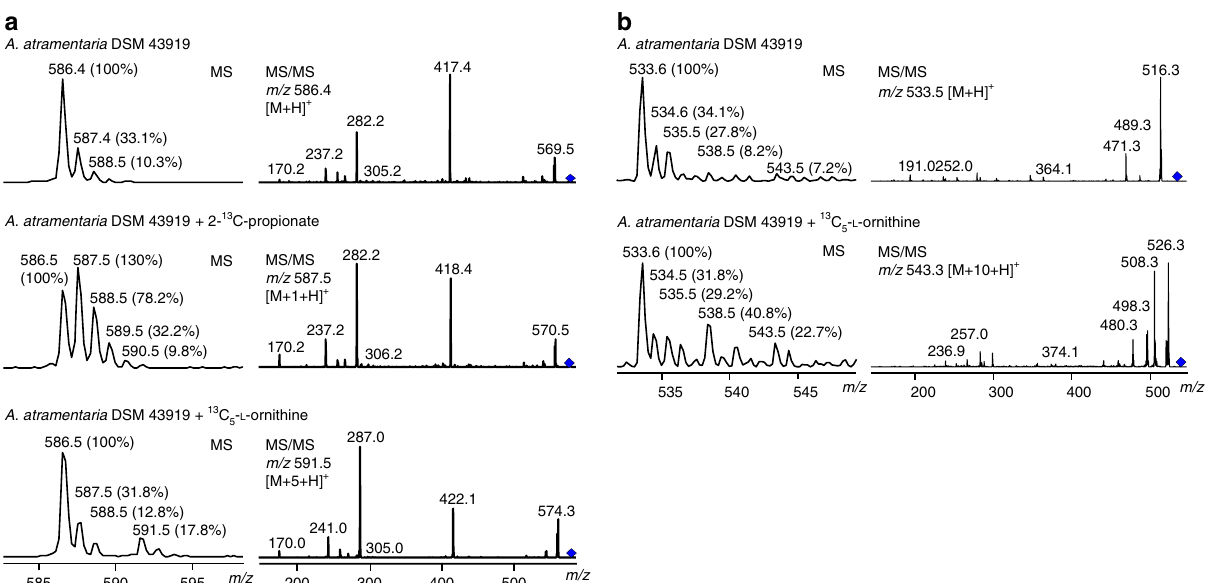
Fig. 4 MS analysis of extracts from cultures of A . atramentaria DMS 43919 with and without supplementation with isotope-labeled precursors. Isotopic distribution and MS 2 spectrum of ( a ) 1a ( m/z 586.4 [M + H] + ) and ( b ) deshydroxymatlystatin D/F ( m/z 533.6 [M + H] + ). Diamonds indicate the precursor ion. All presented chemotypes were reproducible in at least one other culture and one repeated independent